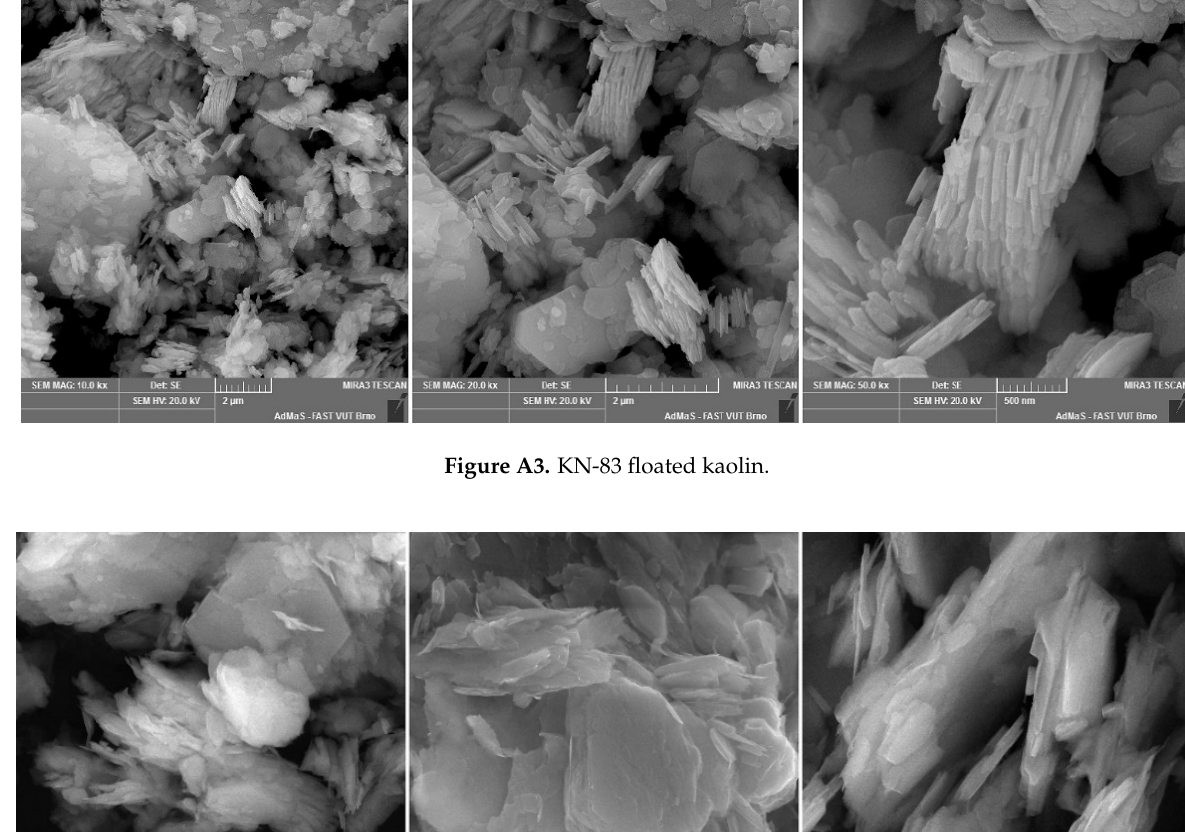
Figure A2. GP3 floated kaolin.